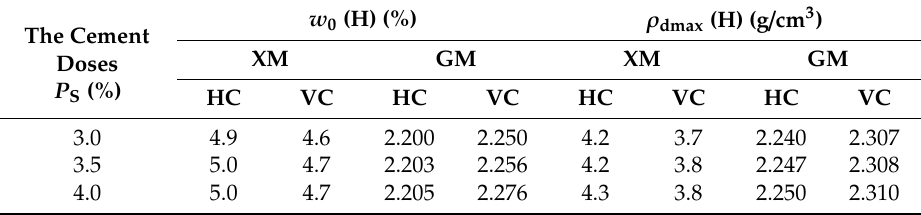
Table 7. The optimal moisture content w 0 and the maximum dry density ρ dmax of the cement stabilized macadam mixture.